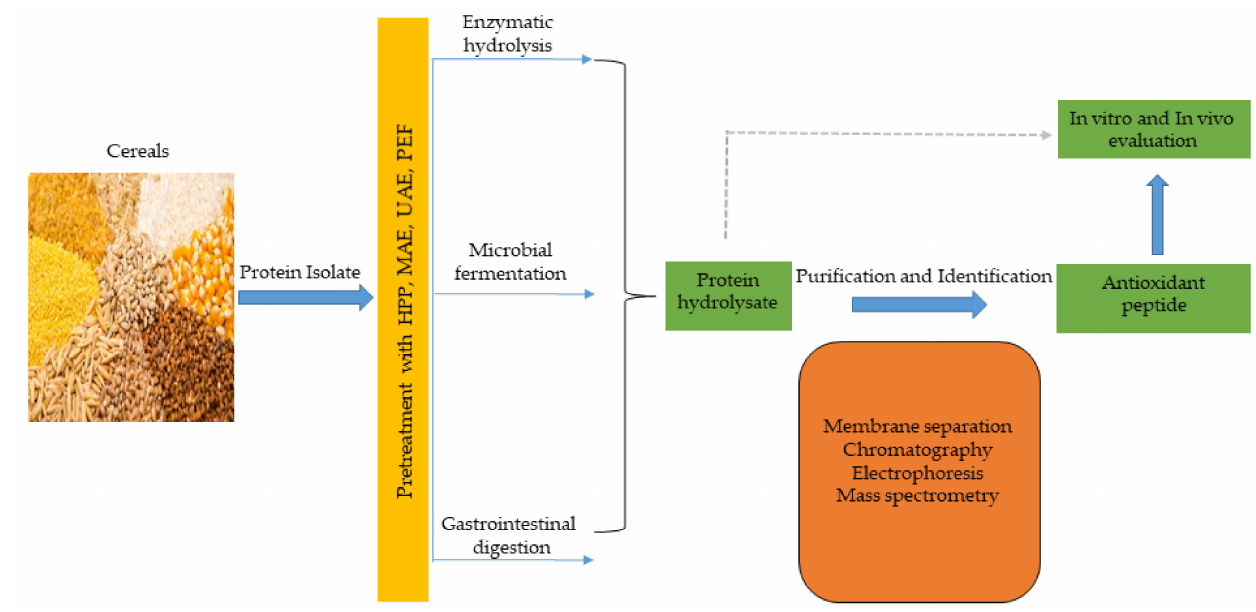
Figure 3. Cereal peptidic antioxidants production